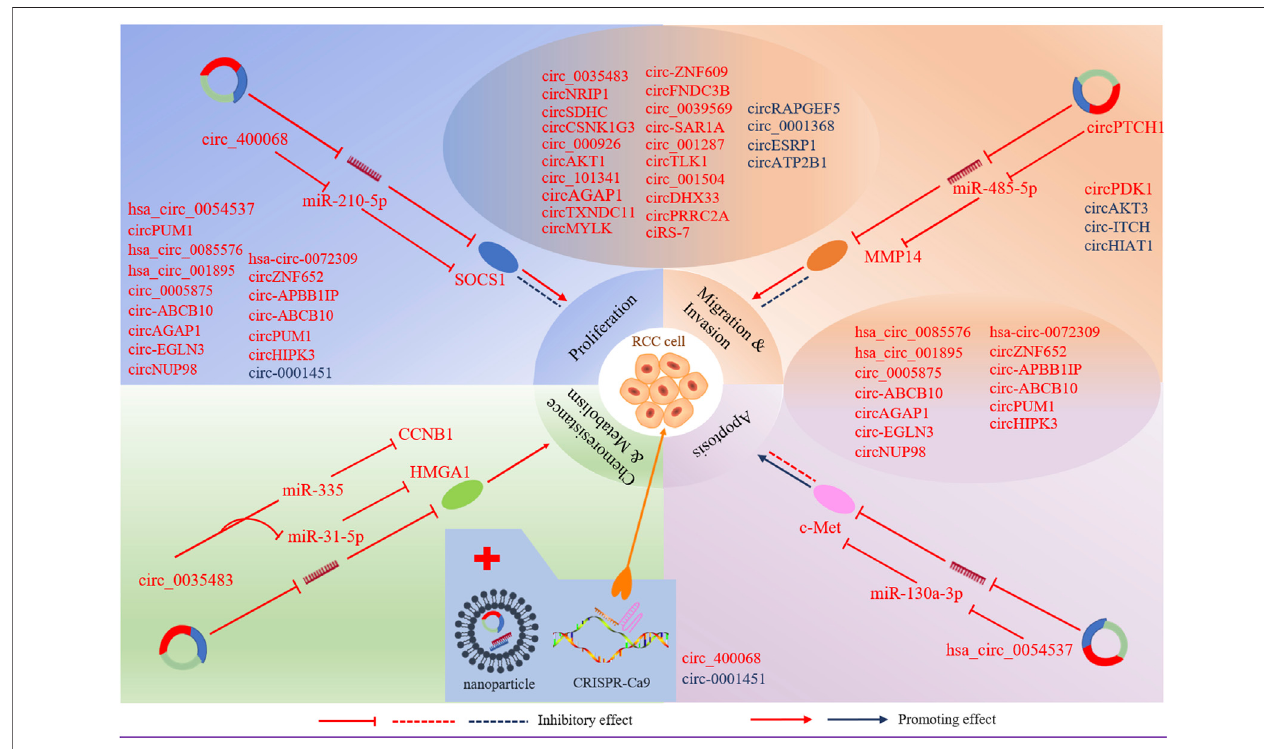
FIGURE 3 | CircRNAs involve in miRNA-associated gene regulatory pathway to regulate RCC cell proliferation, apoptosis, migration, invasion, chemoresistance and metabolism. Selected samples of circRNAs and their genomic targets are exhibited for tumour progression. CircRNAs in red represent up-regulated in RCC, and circRNAs in blue represent downregulated in RCC. Nanoparticles act as delivery vehicles for siRNAs and circRNA expression vectors provide a circRNA -based therapeutic strategy for RCC. CRISPR/cas9 -mediated knockout may be applied to RCC treatment.